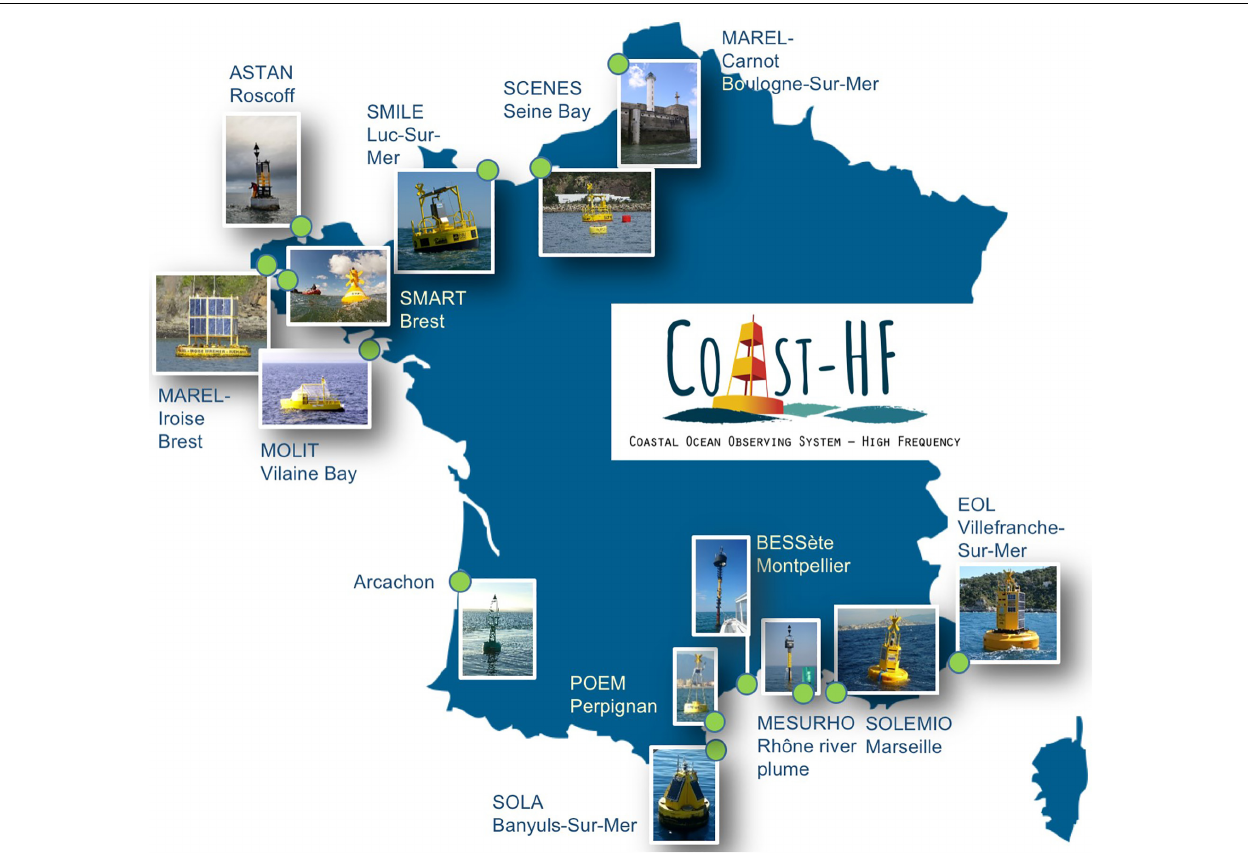
FIGURE 1 | Fixed stations from the COAST-HF observing